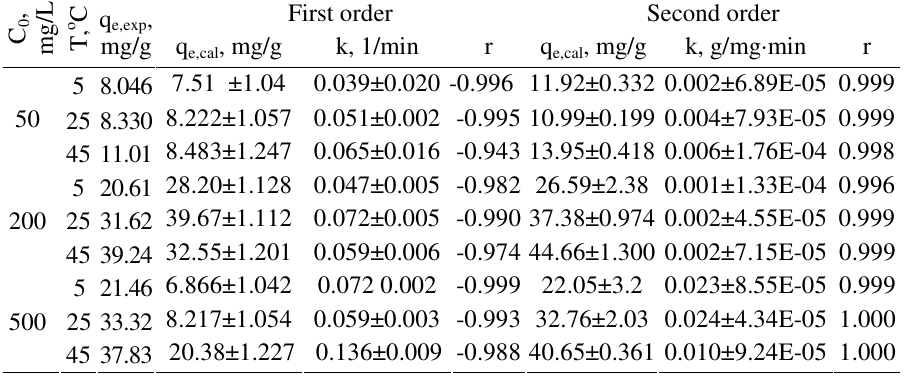
Table 5 . Comparison of the adsorption kinetic models of PEG (4000) on EG First order Second order , C 0